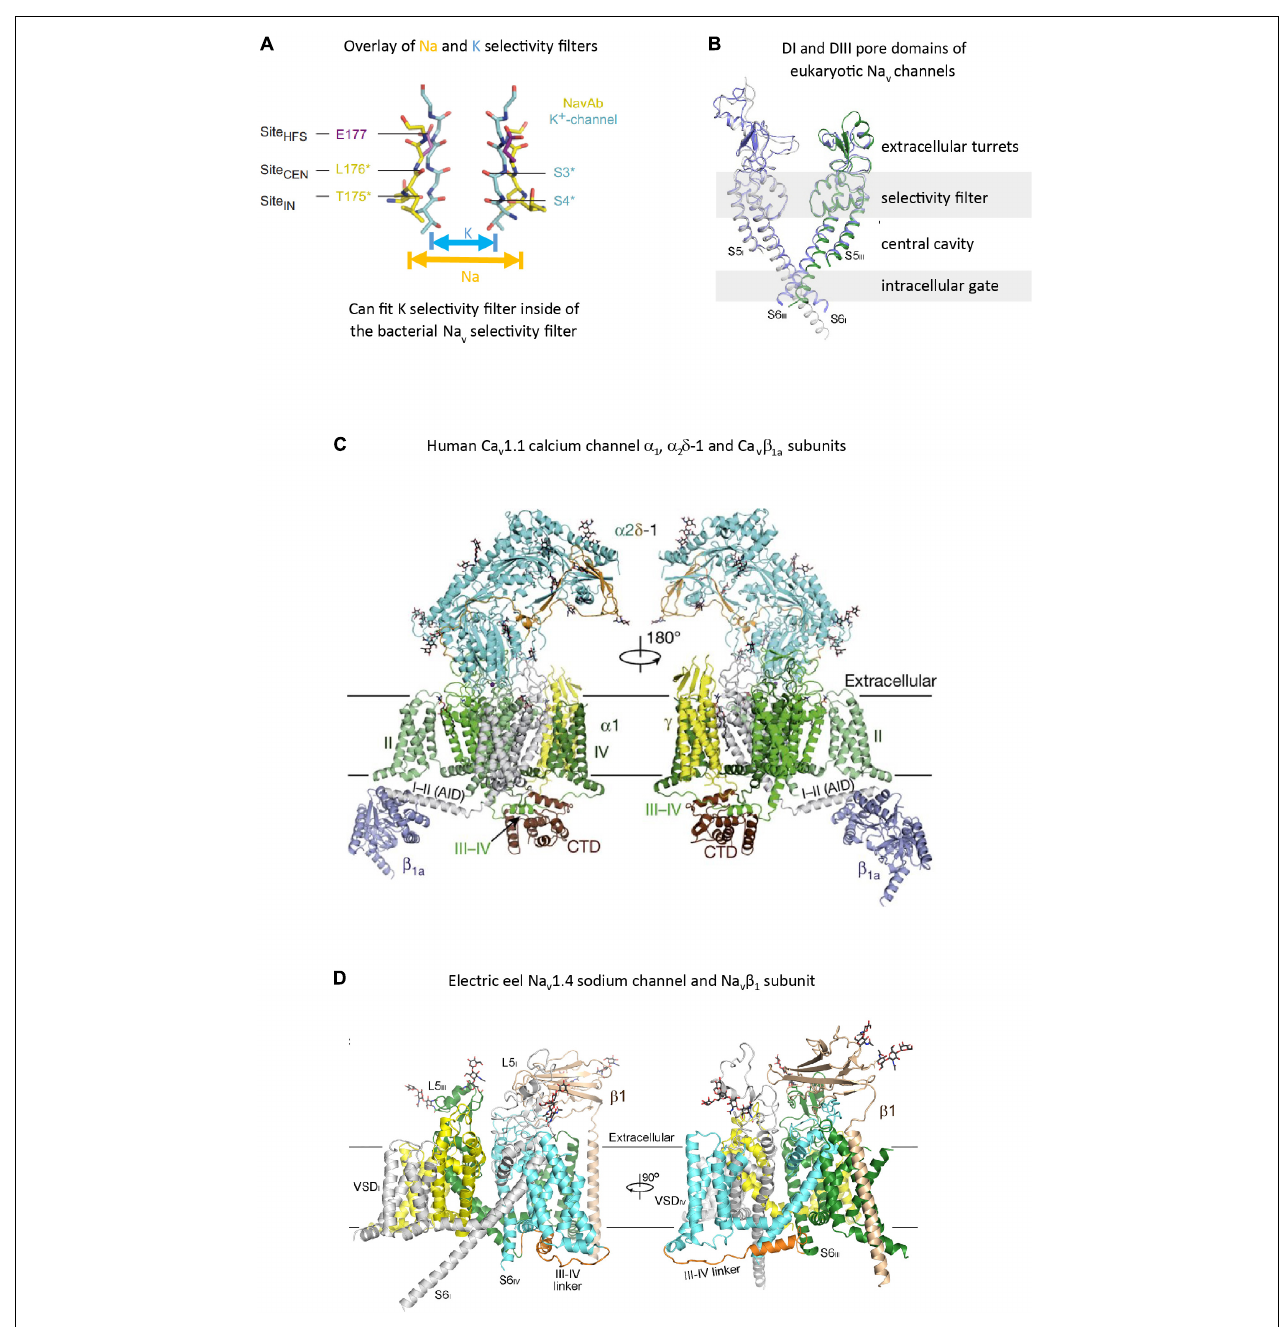
FIGURE 3 | High resolution structures of pore selectivity filters, a pore domain and full length voltage gated calcium and sodium channels. (A) Overlay of the structure of the pore selectivity filter of bacterial KcsA potassium channel (Doyle et al., 1998) and bacterial sodium channel Na v Ab (Payandeh et al., 2012). Only two subunits are shown for clarity. Backbone carbonyls in the selectivity filter are red. The narrower pore selectivity filter for potassium ions fits within the broader selectivity filter for sodium (or calcium) ions. (B) Overlay of Domain I and III pores of arthropod Na v 1 and electric eel Na v 1.4. Key amino acid side chain residues of the selectivity filter project into the pore center to regulate ion passage through sodium and calcium channels pores. Long extensive extracellular turrets rising from segment 5 to the pore selectivity filter, and shorter extensions from the pore selectivity filter to segment 6 project rise above the membrane, serving as a first contact for incoming ions and drugs, before passing through the selectivity filter below. (C) α 1 subunit of the human Ca v 1.1 calcium channel, illustrating the extended extracellular turret loops of L5 I , L5 III , L6 IV and the intracellular globular domain formed by the III-IV linker and the proximal C-terminal Domain (CTD) containing the calmodulin binding IQ motif. The proximal C-terminus omitted in the right panel to better illustrate the III–IV linker. Accessory α 2 (cid:49) -1 and β 1A subunits are illustrated with the pore-forming α 1 subunit. Potential Ca 2 + ions in the selectivity filter vestibule are illustrated as green spheres. (D) The structure of the electric eel Na v 1.4 (each domain individually colored) and β 1(wheat colored) complex, with glycosyl moieties shown as black sticks. The short cytoplasmic III-IV linker (orange color) regulates fast inactivation of Na v 1 channels. (A) reproduced from Payandeh, et al (2011). Nature, 10:475(7356):353-8 with permission. (B,D) reproduced from Yan et al. (2017). (C) reproduced from J Wu et al.